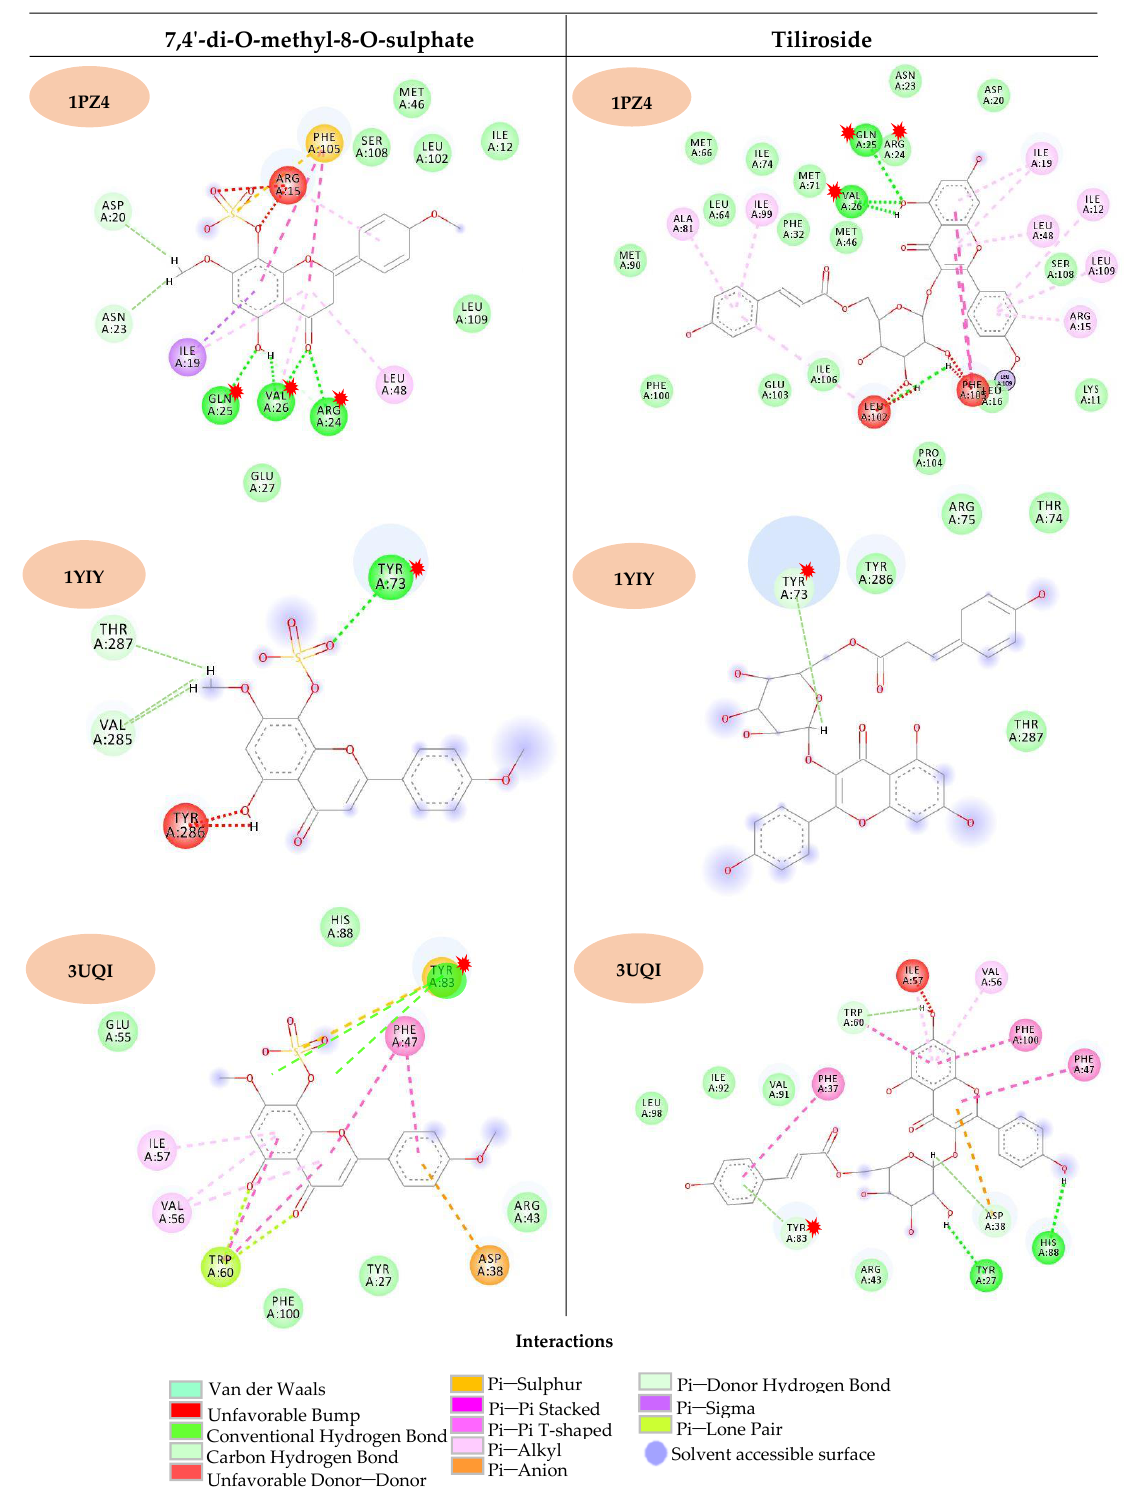
Figure 4. Interactions of the compounds tilirosideo and 7,4 (cid:48) -di- O -methyl-8- O -sulphate flavone with the proteins active sites. The amino acids residues in common for the two substances are marked with a red asterisk and represent the hydrogen